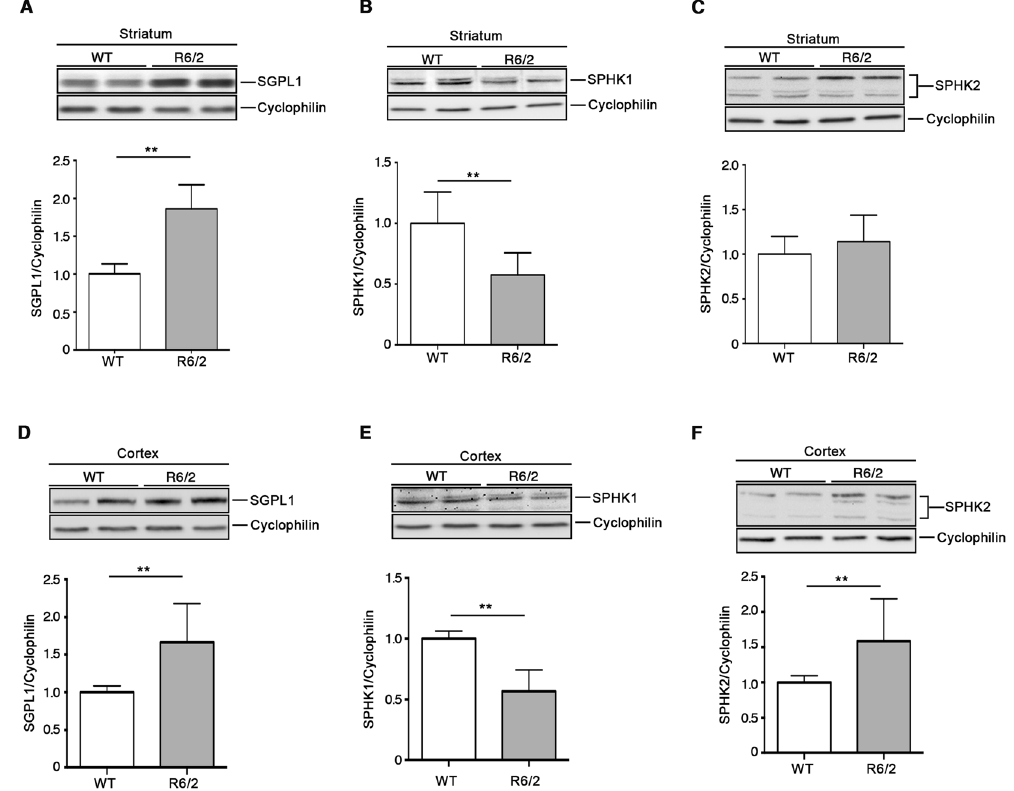
Figure 4. Expression of S1P metabolizing enzymes is defective in brain tissues from R6/2 HD mice. Representative cropped immunoblottings and densitometric analysis of SGPL1 and SPHK1/2 isoform expression in striatal ( A–C ) and cortical ( D,E ) tissues from manifest (11 week old) R6/2 mice and WT littermates. Values are represented as mean ± SD. N = 6–9 for each group of mice. ** p < 0.001 (Unpaired